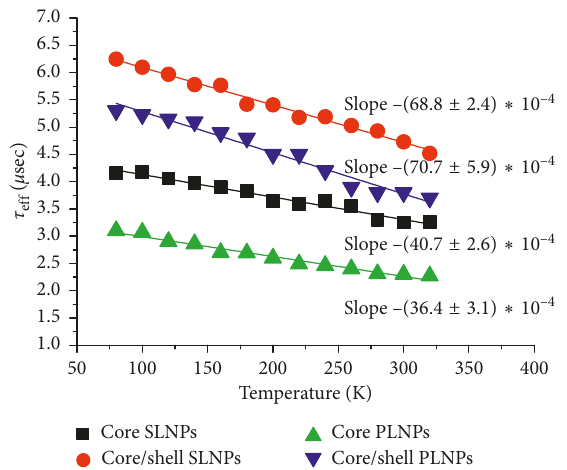
Figure 11: The values of τ